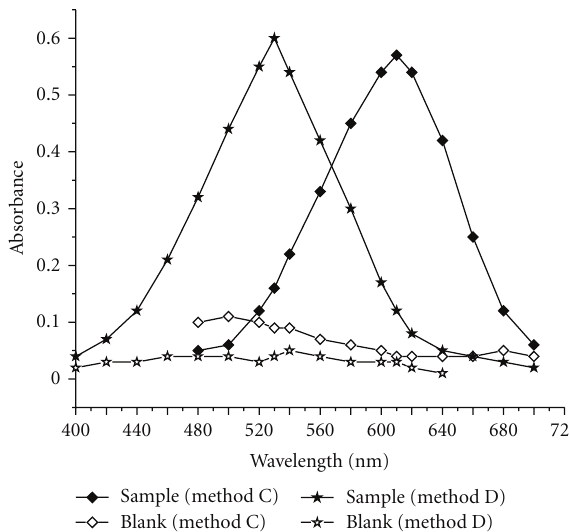
Figure 3: Absorption spectra (4.5 μ g mL − 1 FMT in method C and 1.8 μ g mL − 1 in method